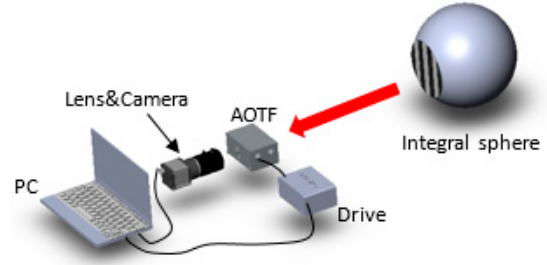
Figure 7. The experiment setup of the camera response contrast. The cut-off wavelength of the AOTF was 1319 nm and the AOTF aperture was the aperture stop in the experiment. The focal lengths of the lenses were 8 mm and 73 mm.